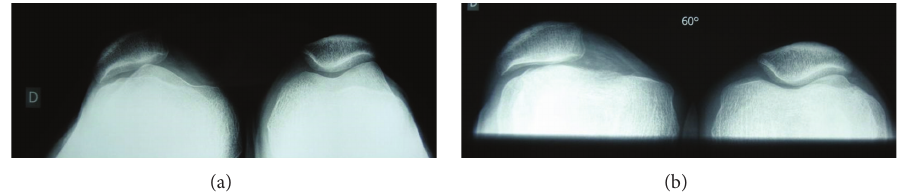
Figure 3: Preoperative patellofemoral X-ray, tangential view in neutral rotation: (a) 30 ∘ flexion and (b) 60 ∘ flexion.